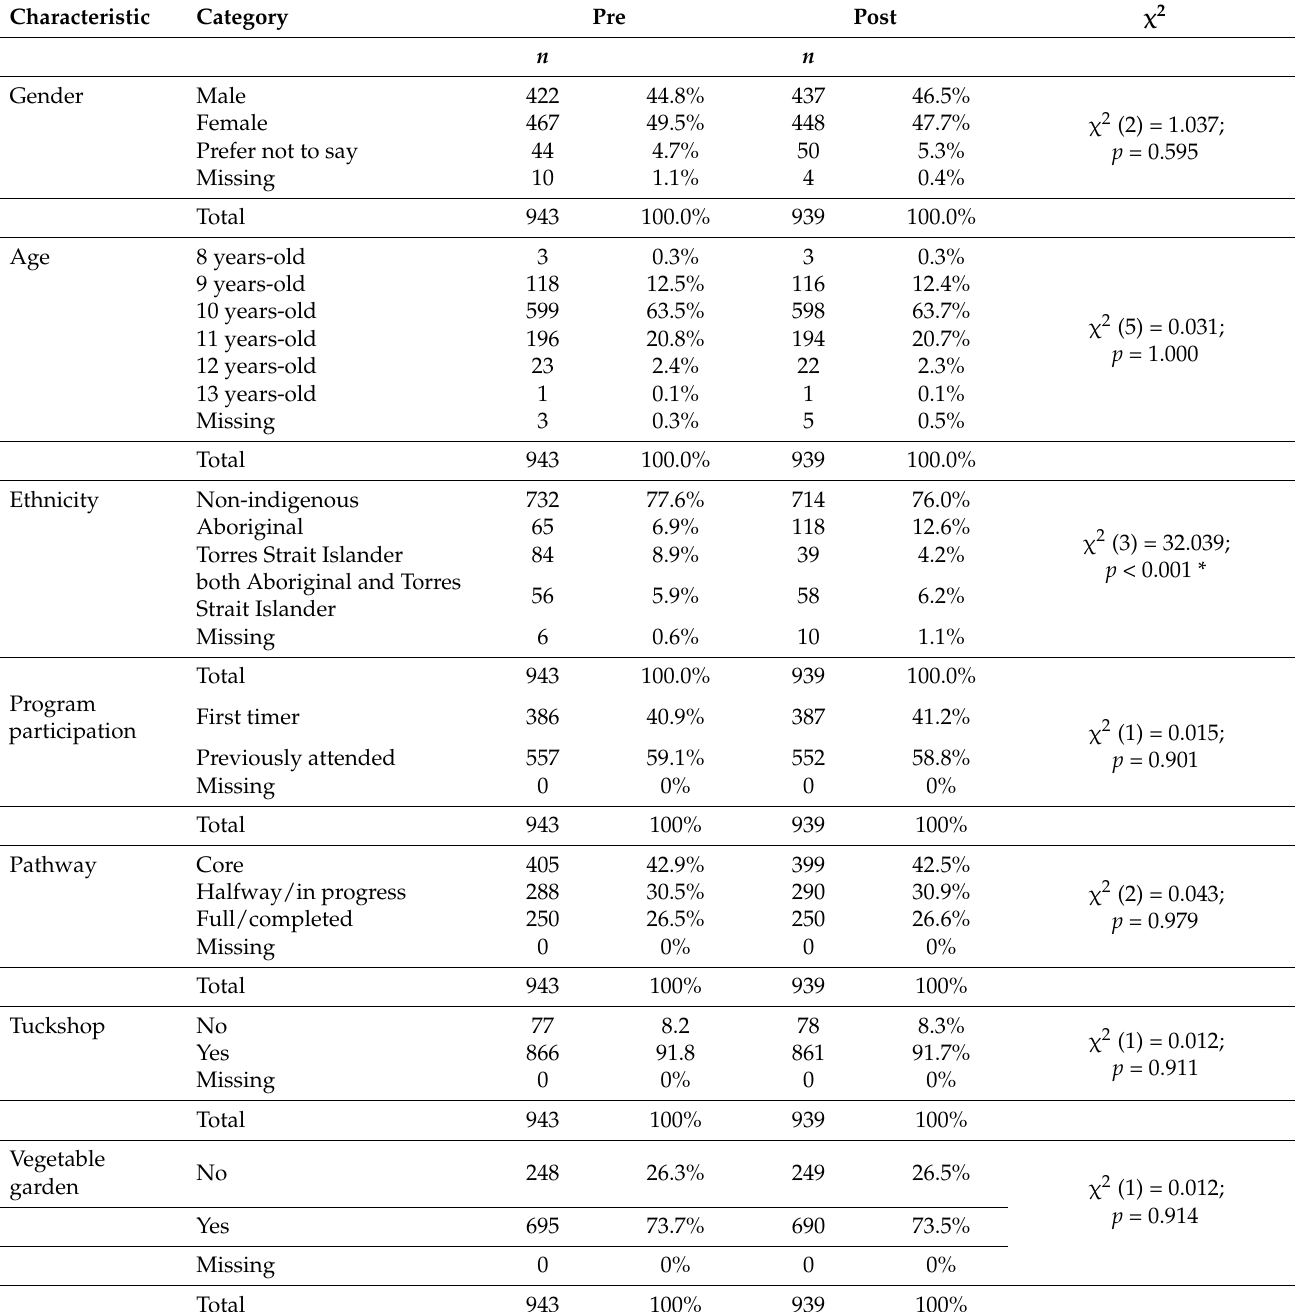
Table 1. Sample demographics–Nutrition Module (Knowledge